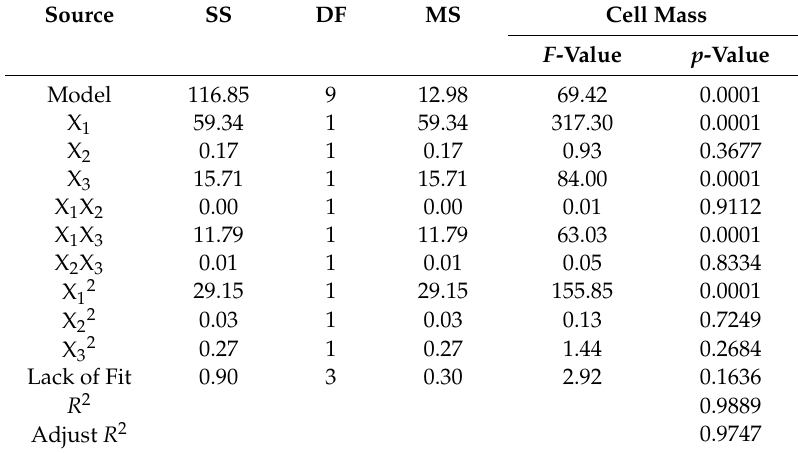
Table 2. Analysis of variance for the quadratic response surface model on first-stage cultivation process. Source SS DF MS Cell Mass F -Value p -Value Model 116.85